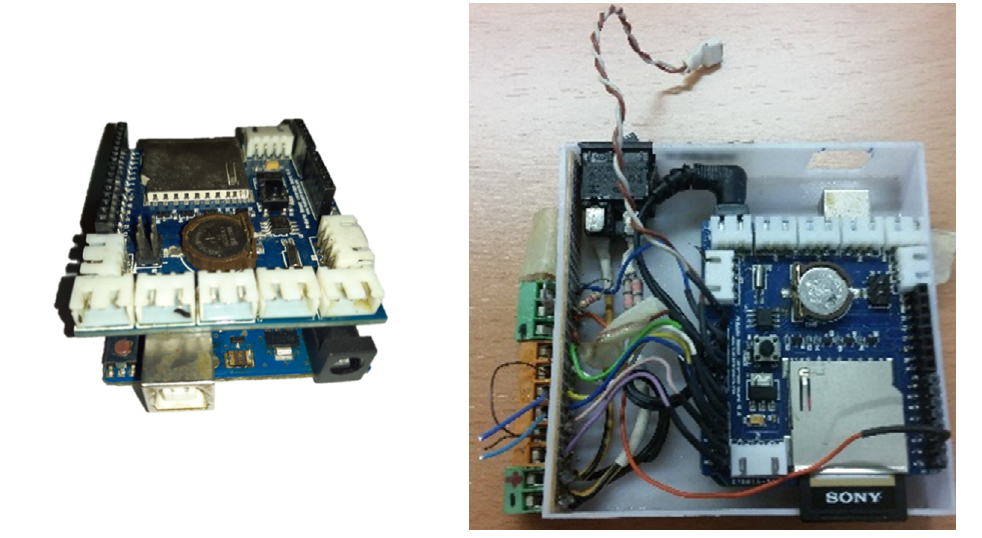
15 of 30 Figure 16. Arduino UNO card and Shiel SD Nuelectronics card (from Nuelectronics.com, accessed on 1 January 2020). The Shield SD card was powered by the Arduino UNO itself, through the 5 V GNS, but it had a 3 V CR1220 button cell which was used to keep the card’s RTC operational if the 7 V power supply failed. It should be emphasized that it was possible to read the data collected on the SD card while the system was operational. The SD card was then read in an external device, rein-